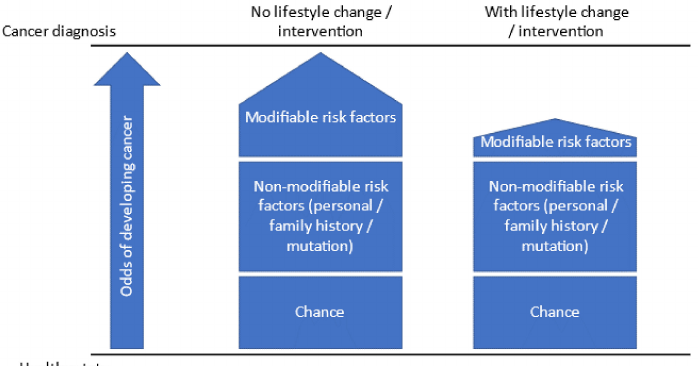
Figure 1. Addressing behavioral factors in people with increased risk for cancer can decrease their odds of developing cancer.